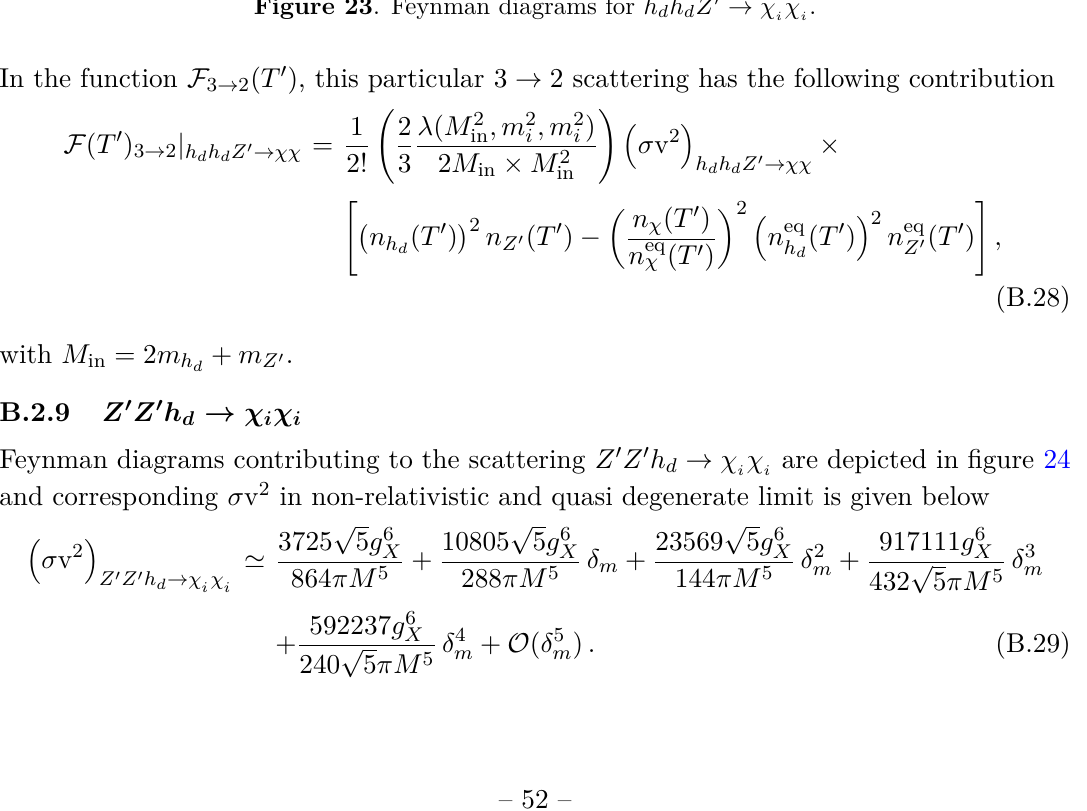
Figure 23 . Feynman diagrams for h d h d Z 0 → χ